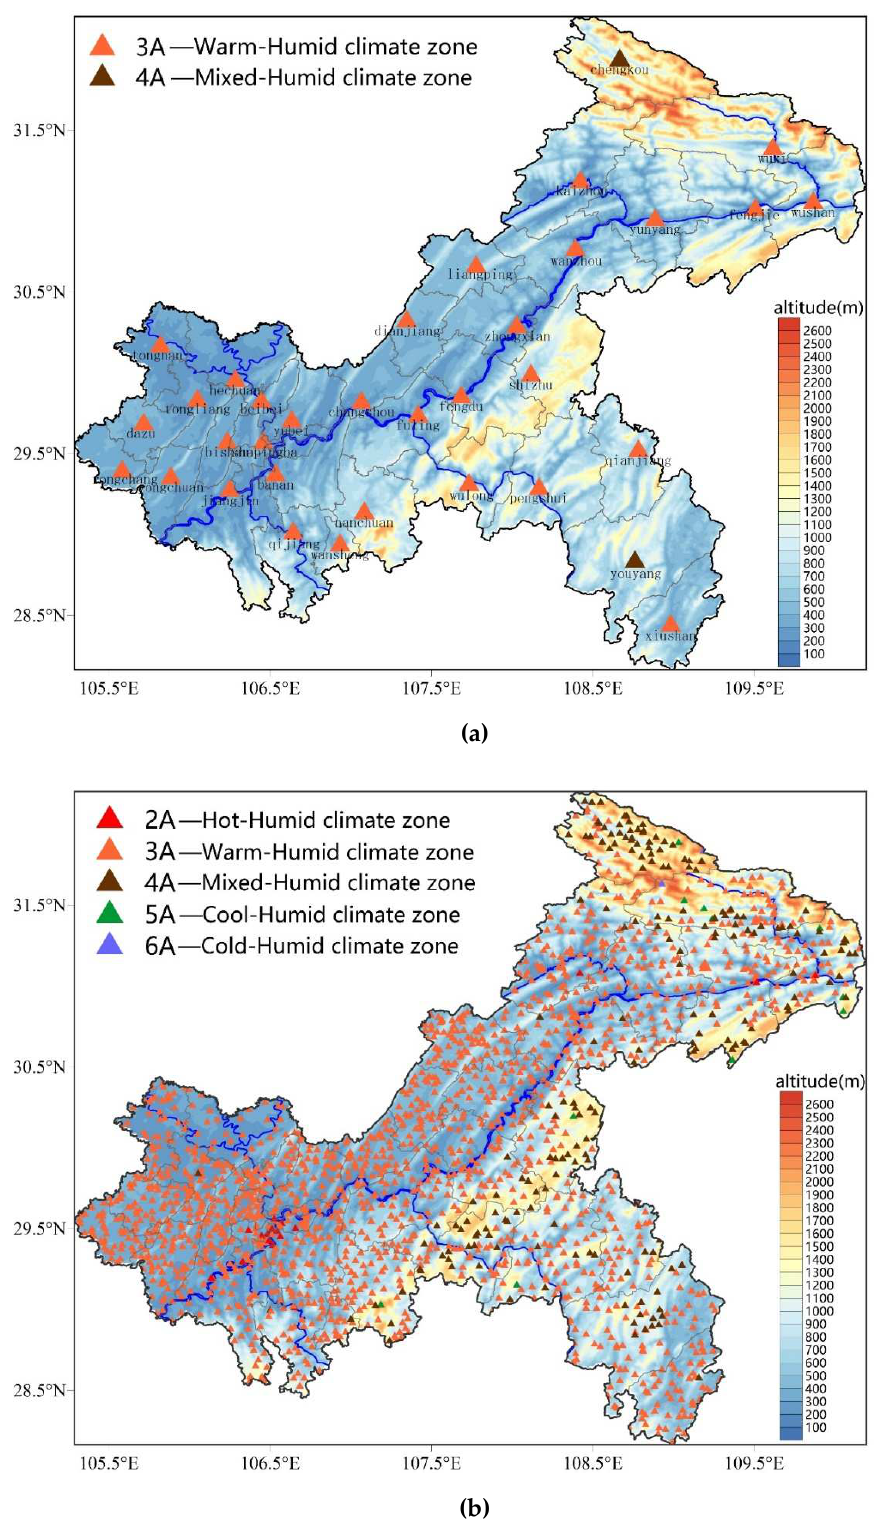
Figure 4. Results of building climate zoning ( a ) and refined climate zoning ( b ) in Chongqing based on the ASHRAE standard.